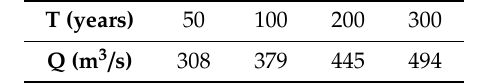
Table 1. Values of peak discharges Q for different return times T from the FFC (flood frequency curves).